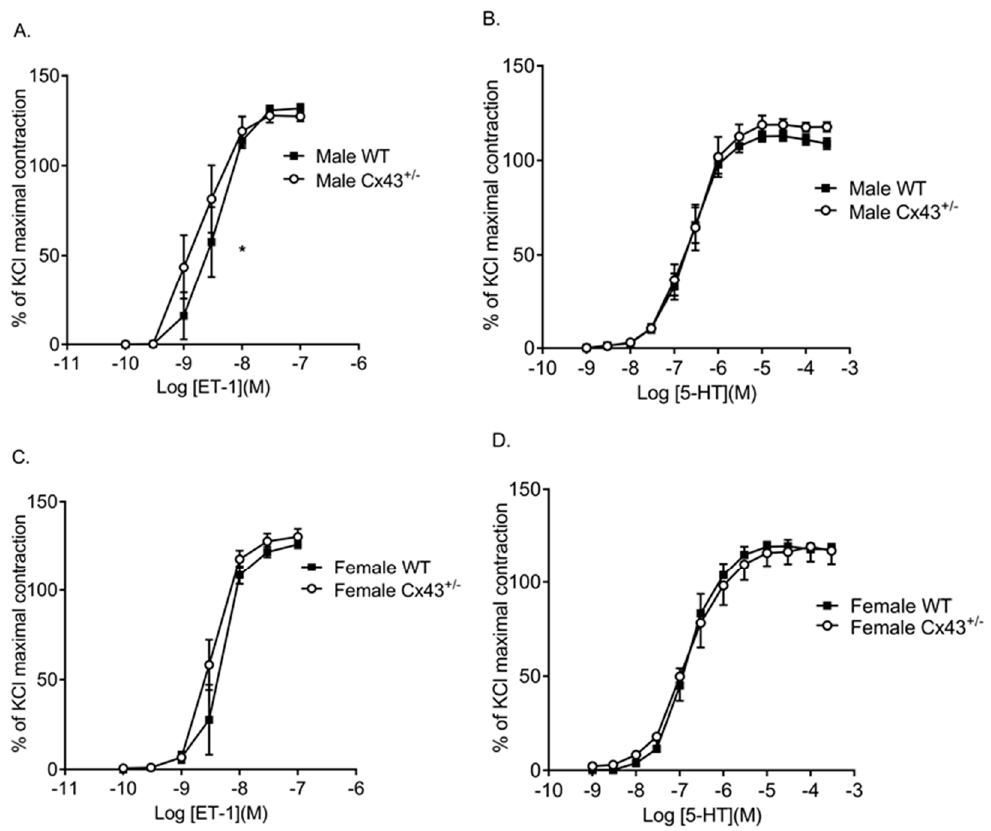
Figure 3. Pulmonary vascular contractility to ET-1 and 5-HT in intralobar pulmonary arteries (IPAs) from male and female wildtype (WT) and Cx43 heterozygous ( Cx43 +/ − ) mice. ET-1 was more potent in IPAs from male Cx43 +/ − mice than WT mice ( A ). There was no difference in contractile response to 5-HT in IPAs from male WT and Cx43 +/ − mice ( B ). There was no difference in ET-1 ( C ) or 5-HT ( D ) induced contractile response in IPAs from female WT or Cx43 +/ − mice. Data are shown as mean ± S.E.M. Global differences in concentration response curves were compared by two-way ANOVA. Changes in logarithm of median effective concentration (Log EC 50 ) and maximal contractile responses (E max ) between two different groups were analyzed by using the Student’s t -test. * EC 50 is significantly ( p < 0.05) reduced in male Cx43 +/ − mice, n = 5–7 per group. Table 1. The contractile effects of ET-1 and 5-HT in IPAs of male and female wildtype (WT) and Cx43 heterozygous ( Cx43 +/ − ) mice. Global Shift in Concentration Agonists Groups Log EC 50 (M) E max (%) Response Curve